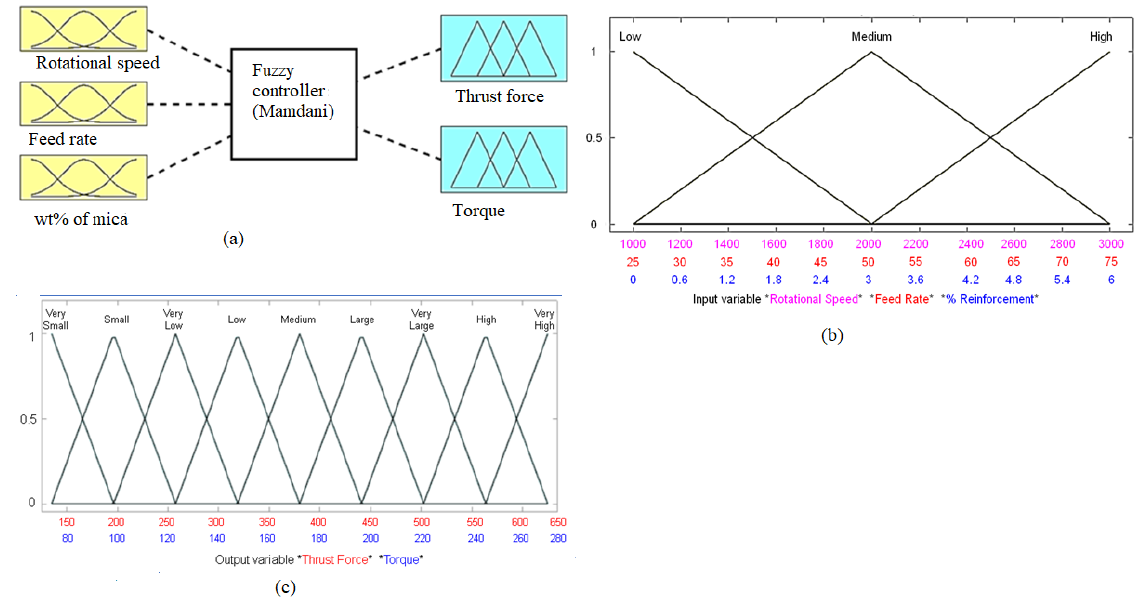
Figure 6. ( a ) Fuzzy inference system model ( b ) Triangular membership function with 3 subsets for inputs ( c ) Triangular membership function with 9 subsets for outputs.